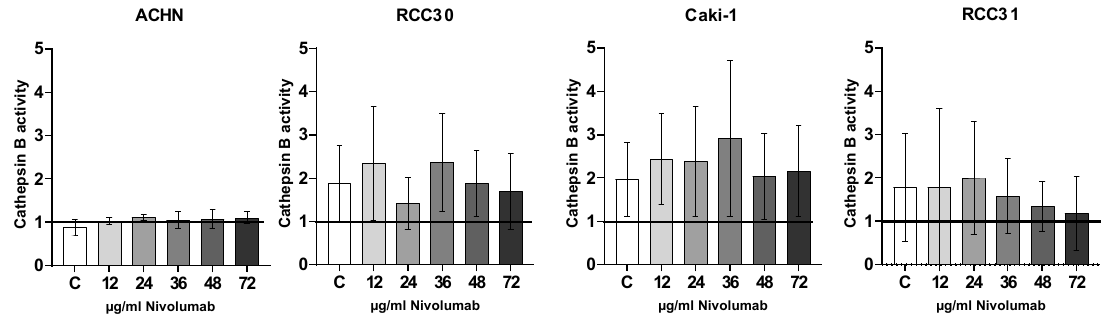
Figure 6. Cath B in RCC cells. Cath B activity after incubation with increasing concentrations of nivolumab. The activity in each cell line after using a specific inhibitor was defined as “1”.